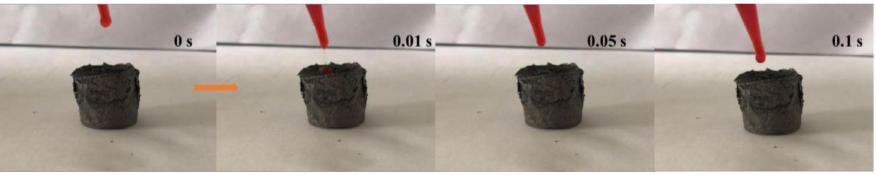
Figure 10. Lipophilicity of aerogels.